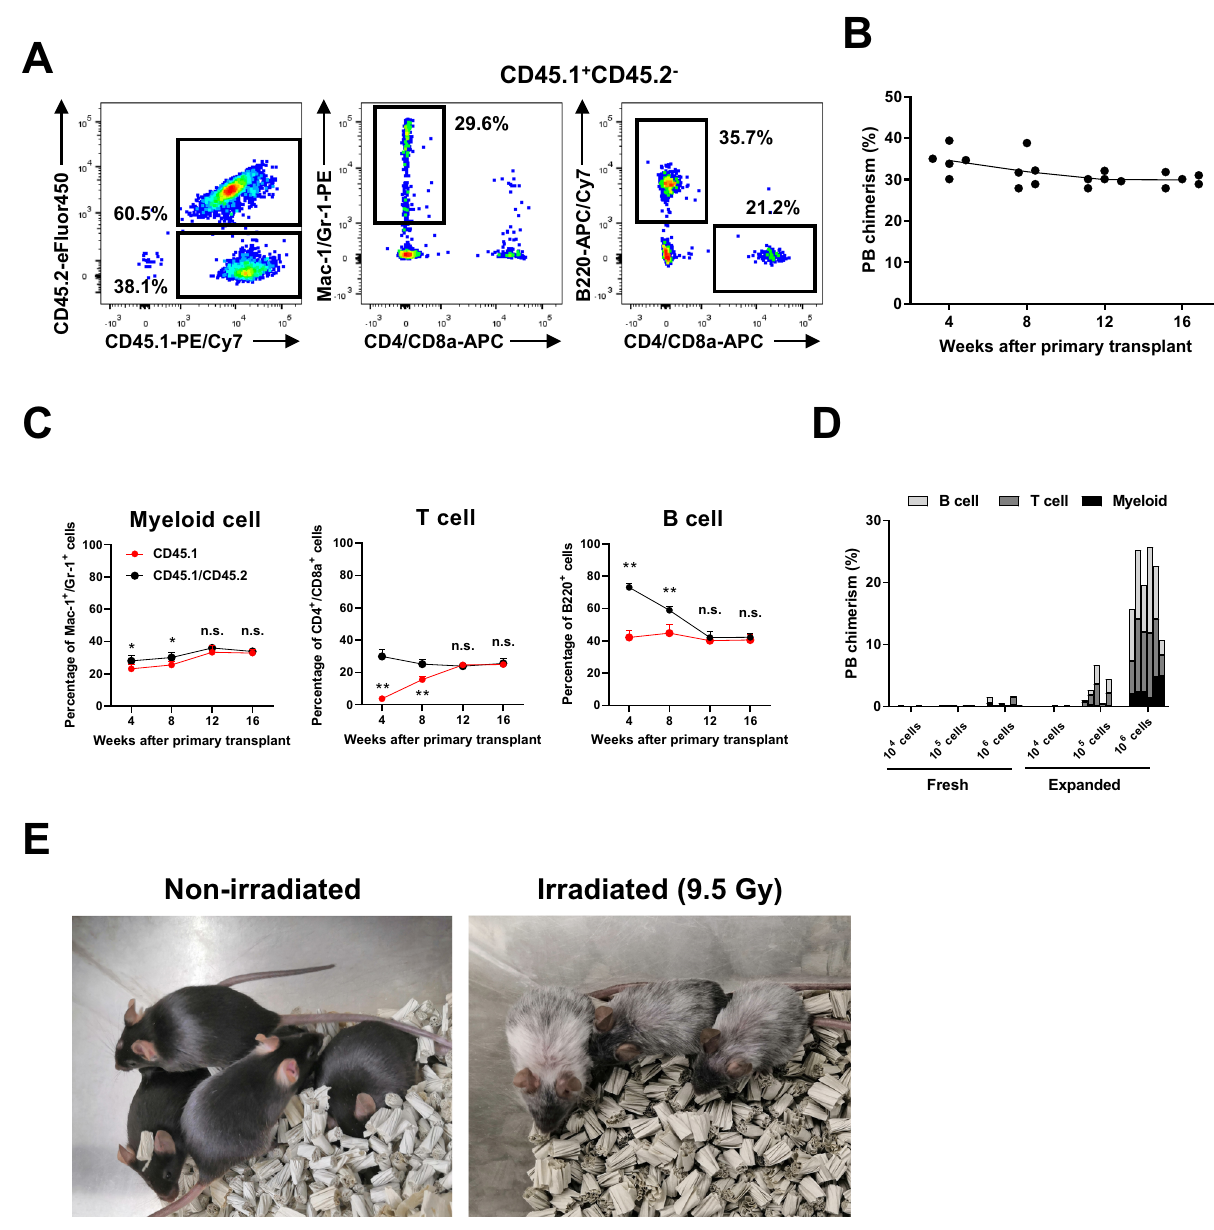
Fig. 3 Generation of irradiation-free BM chimeric mice. A Gating strategy used to detect donor-derived CD45.1 + PB chimerism in non-conditioned C57BL/6-CD45.1/CD45.2 recipients. B Percentage of donor-derived CD45.1 + cells after primary transplant of 1 × 10 6 28-day cultured c-Kit + BM cells ( n = 5 mice). C Percentage of Mac-1 + /Gr-1 + (myeloid cells), CD4 + /CD8a + (T cells), and B220 + (B cells) among donor- and recipient-derived CD45.1 + cells